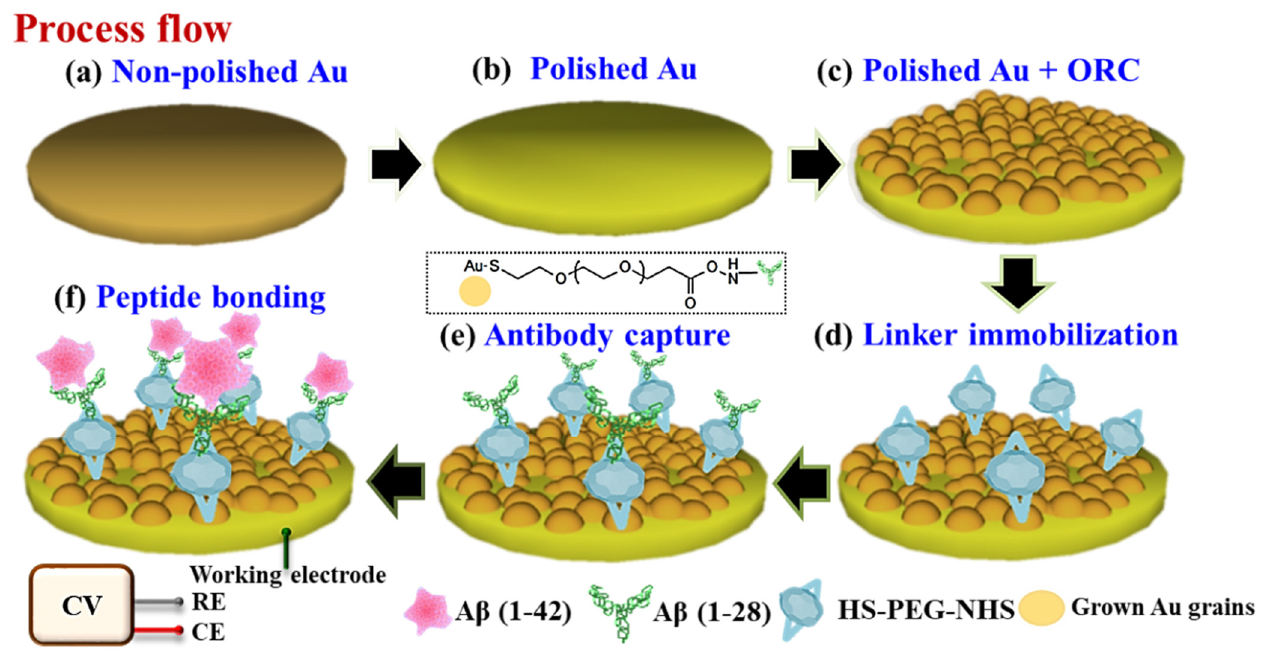
Figure 1. Schematic illustration of ORC nanorestructuring and surface modification of Au substrate for A β (1–42) peptide detection.